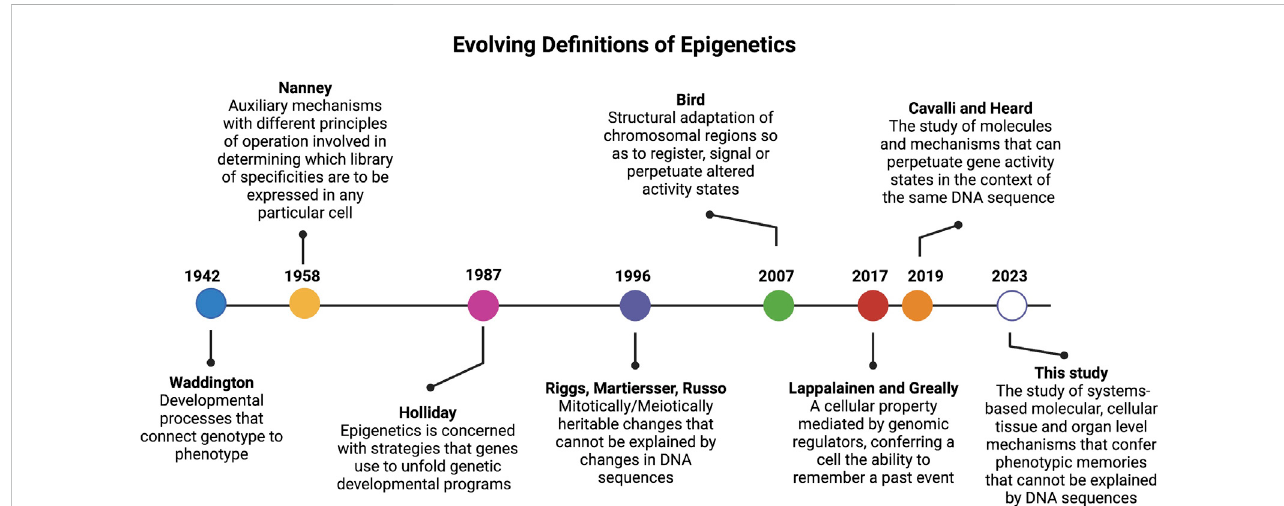
FIGURE 1 Timeline ofepigeneticde fi nitions since the termwas fi rst coined byConrad Waddington in 1942. Updated epigenetics de fi nitions re fl ect key discoveries and understanding over the past 80 years.